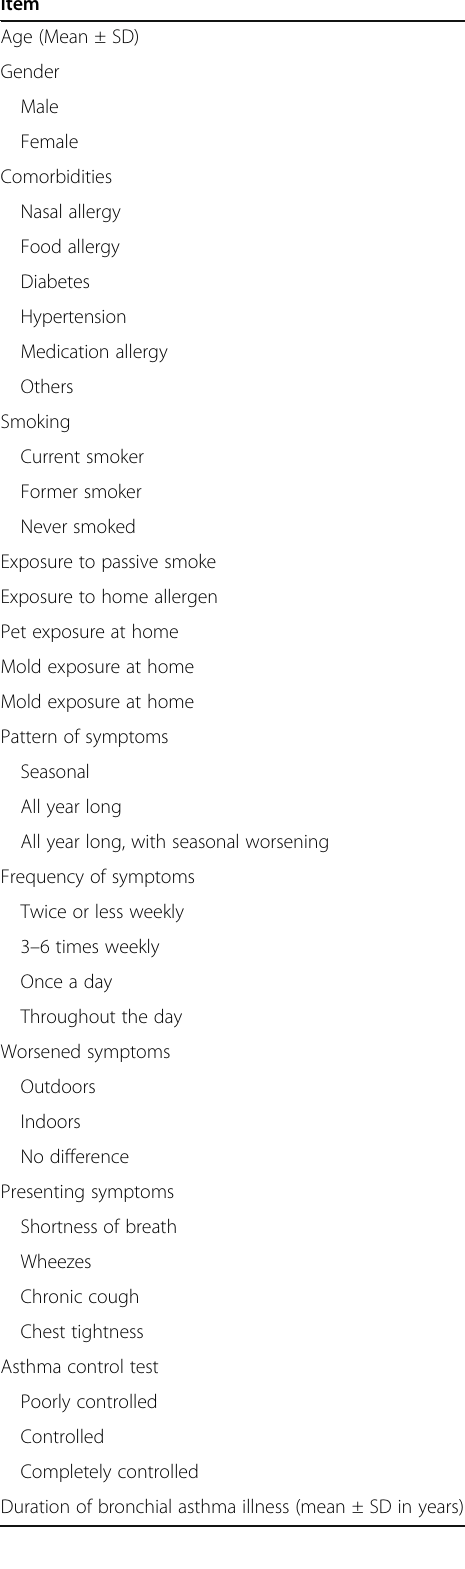
Table 1 Personal and medical data of the study